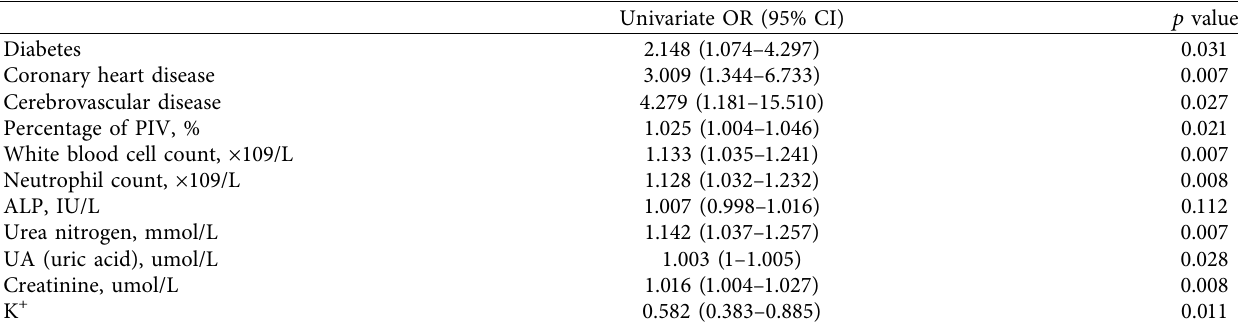
Table 4: Univariate logistic regression analysis of patients with COVID-19 and hypertension.